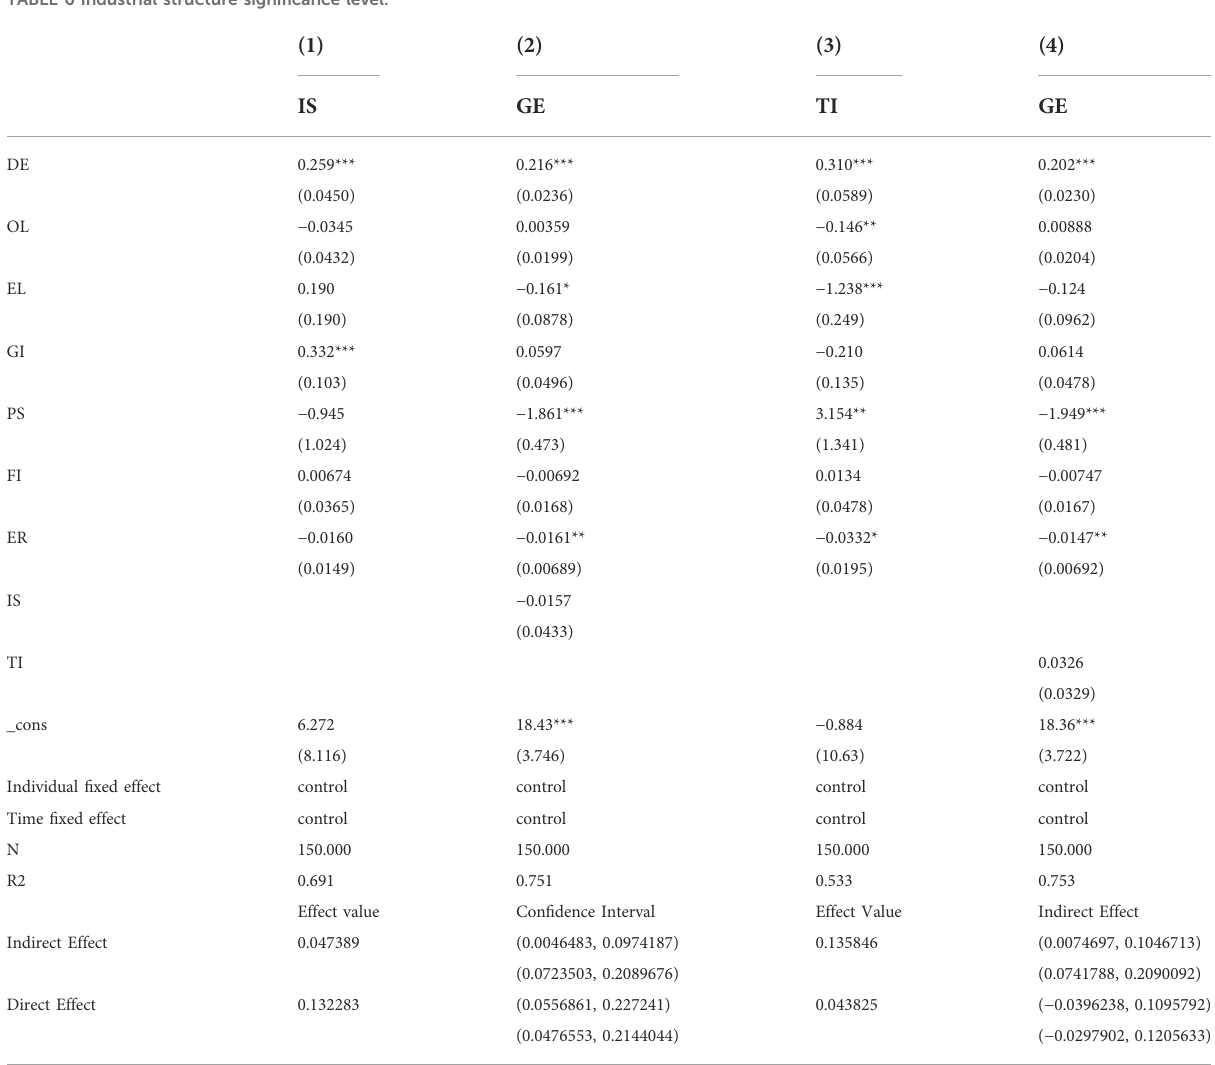
TABLE 6 Industrial structure signi fi cance